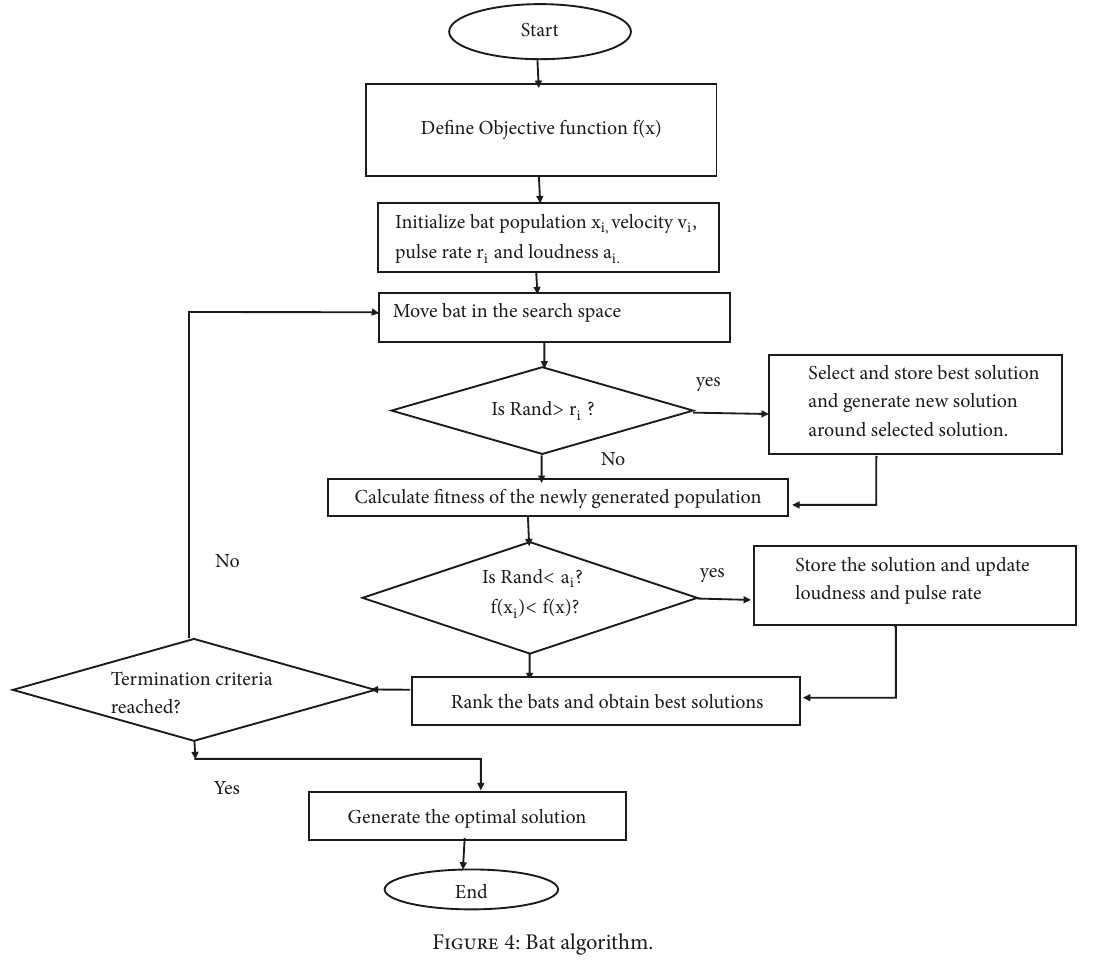
Figure 4: Bat algorithm.